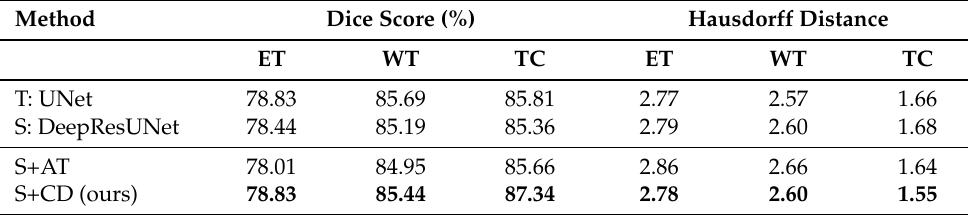
Table 3. Comparison with AT on the